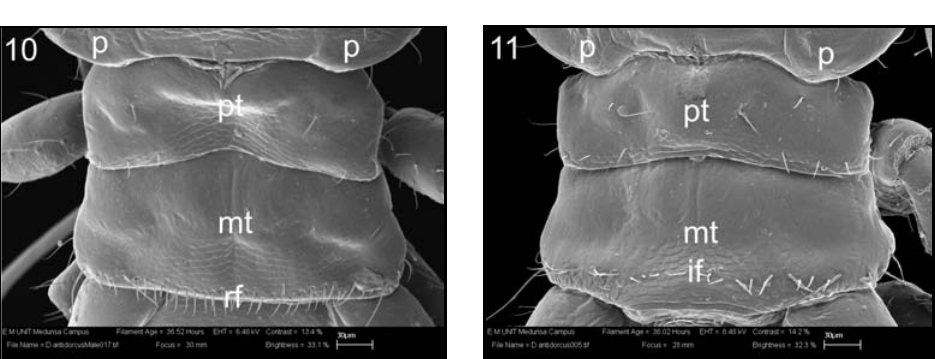
Fig. 10 & 11. The posterior edge of the meso-thorax (mt) of the male with its regular transverse fringe (rf) of seta and the dimorphic difference in the female respectively. (p) = parietal area, (pt) = pro-thorax, (if) = irreg- ular fringe.